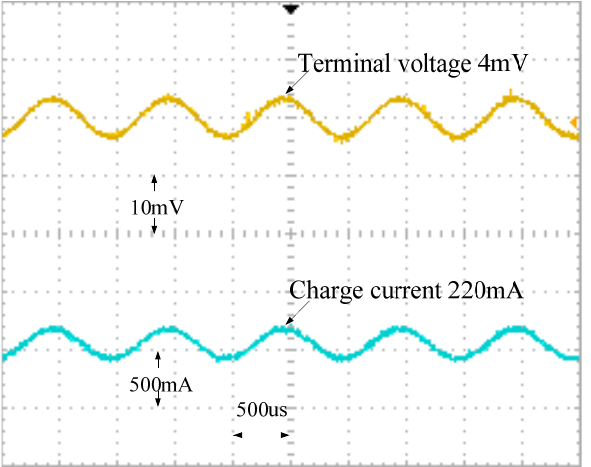
Figure 15. The filtered DC components charge current and the terminal voltage